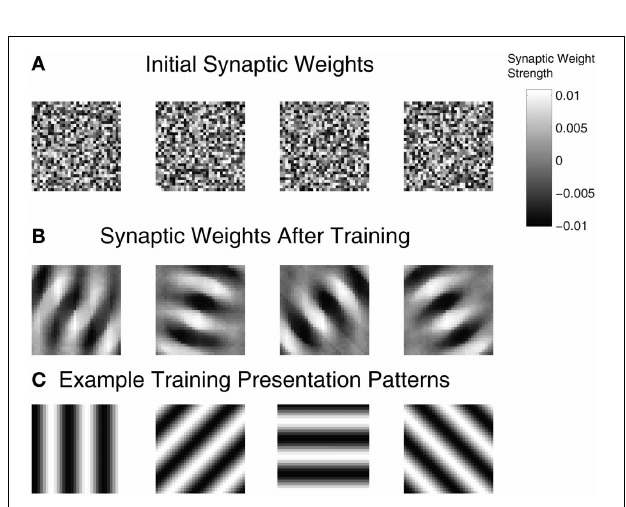
FIGURE 6 | Synaptic weights for the On(Off)Buffer → Exc connections of a high fitness SNN individual. (A) Initial weight values before training. (B) After training for approximately 100 simulated minutes with STDP and homeostasis, the synaptic weight patterns resemble Gabor filters. (C) Four example orientation grating patterns are shown.